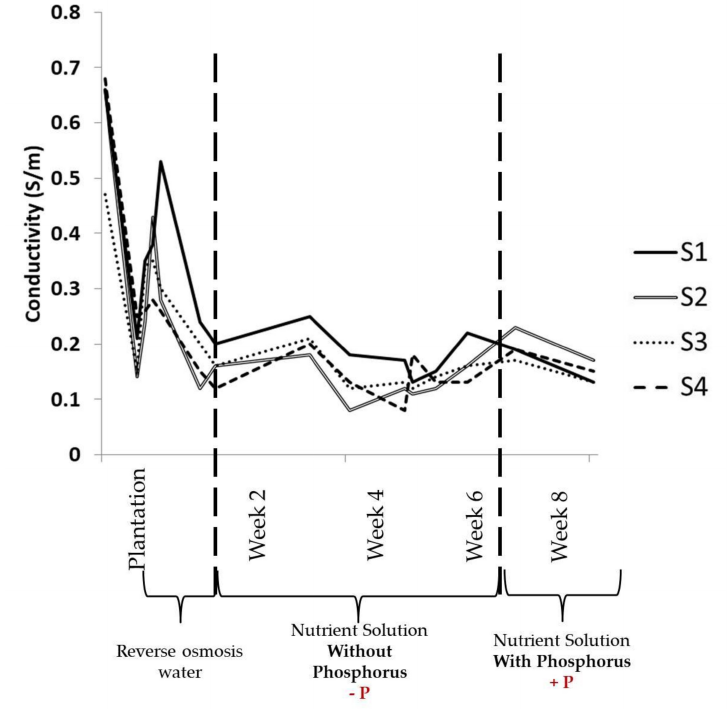
Figure 2. Evolution of conductivity value (S/m) values of the drainage water collected at the level of the different substrates (S1: 100% coconut fiber; S2: 66% coconut fiber + 33% bagasse; S3: 50% coconut fiber + 50% bagasse; S4: 33% coconut fiber + 66% bagasse) before planting and up to 10 weeks after